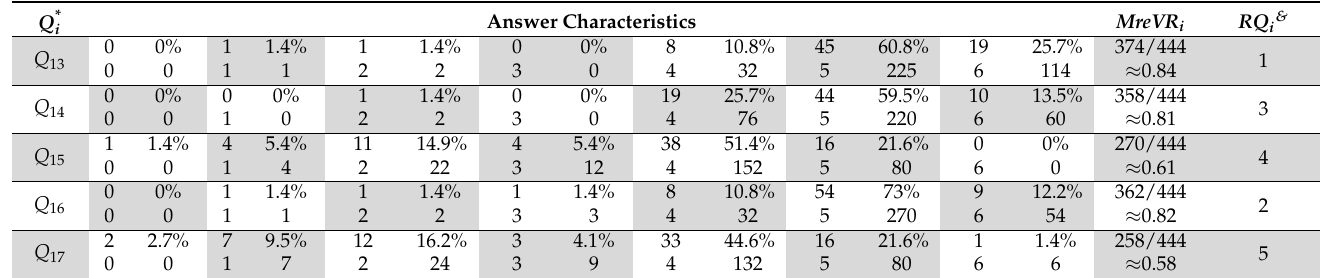
Table 16. Sales determinants of sustainable marketing mix development. Answer